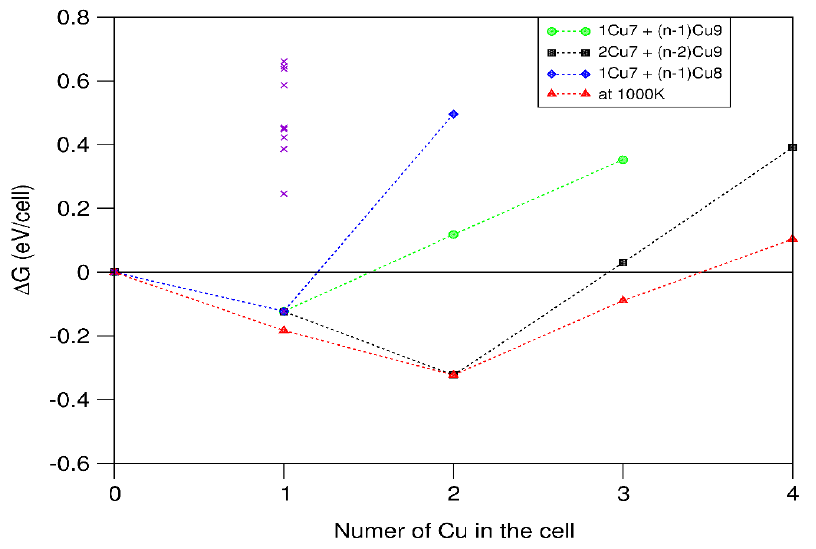
Figure 4. (Color on line) Dependence of substitution energy on Cu concentration for configurations of high stability at 0 K and related free energy at 1000 K.